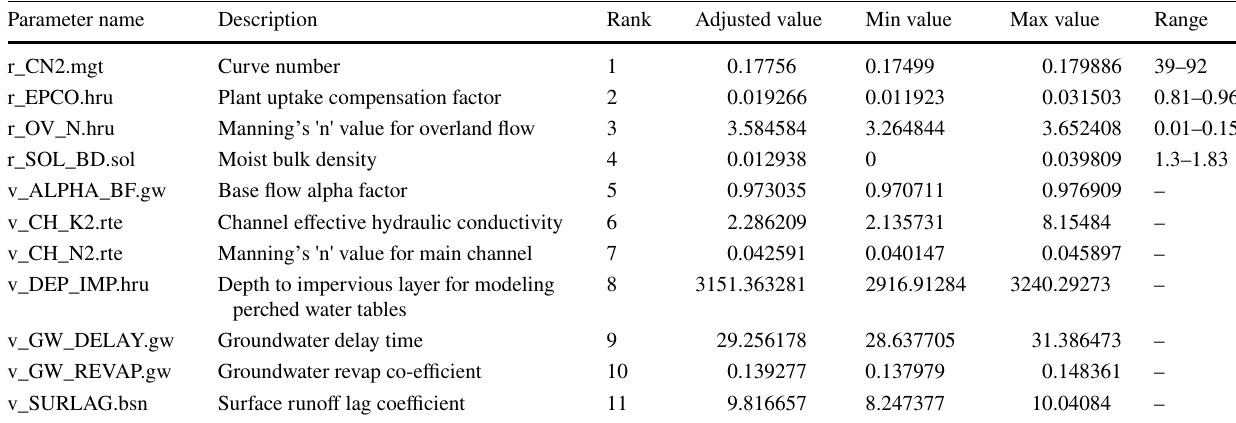
v: Means the existing parameter value is to be replaced by the fitted parameter value r: Means an existing parameter value is multiplied by (1 + fitted